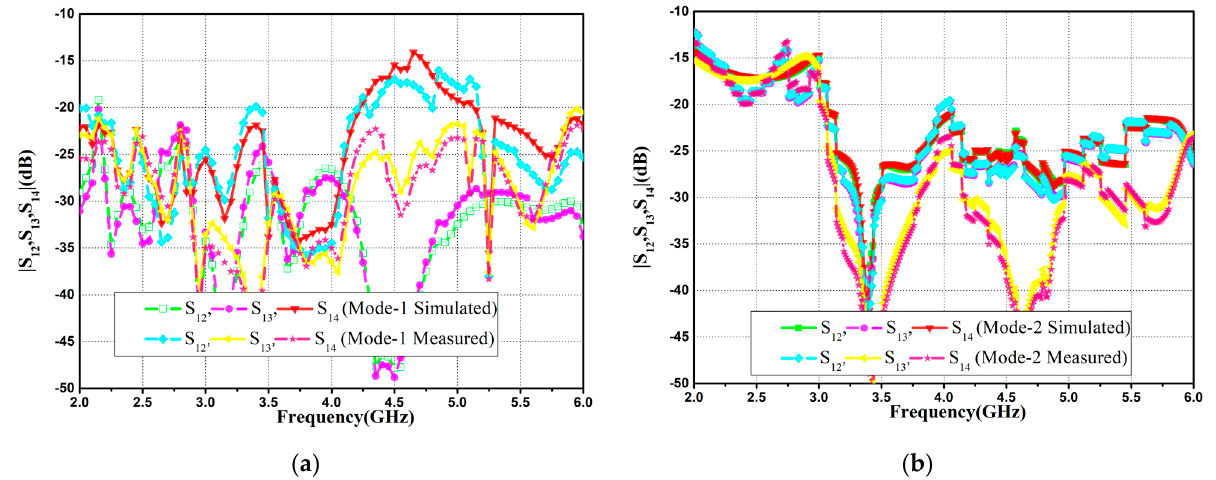
Figure 8. Scattering parameters of the MIMO antenna: ( a ) Mode-1; ( b ) Mode-2.